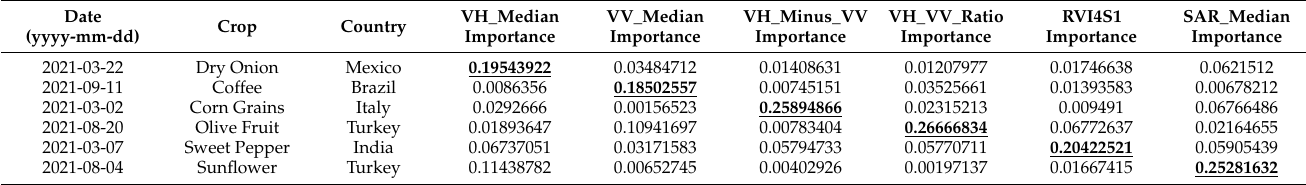
Table 4. Examples of different indices having the highest importance score (bold with underline) for different dates and fields.